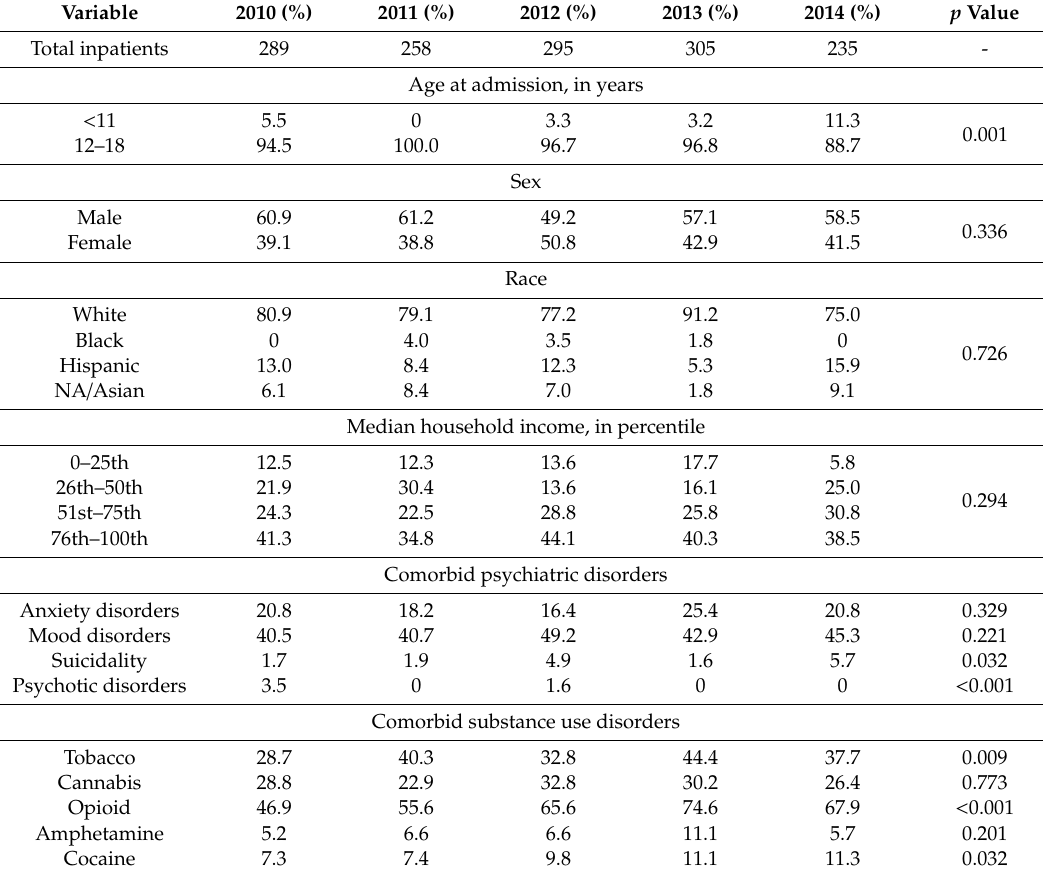
Table 2. Trends in child and adolescent inpatients with heroin opioid